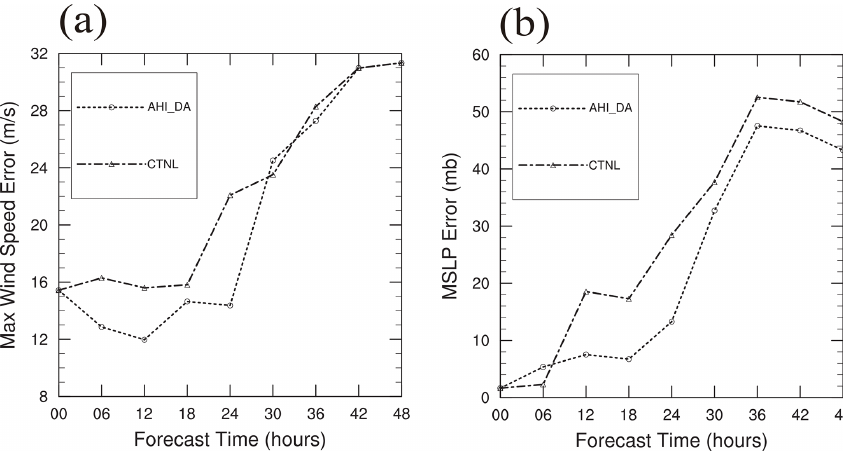
Figure 13. The 48h (a) maximum surface wind error (unit: ms − 1 ) and (b) minimum sea level pressure error (unit: hPa) of Soudelor (2015) averaged from two